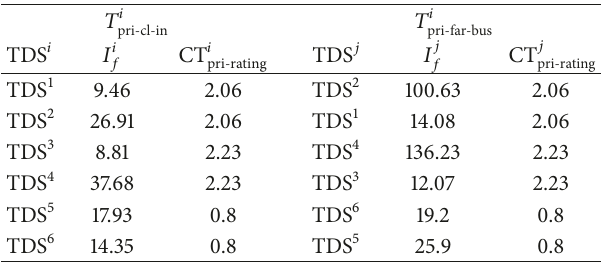
and 𝑇 of 3-bus model. backup primary